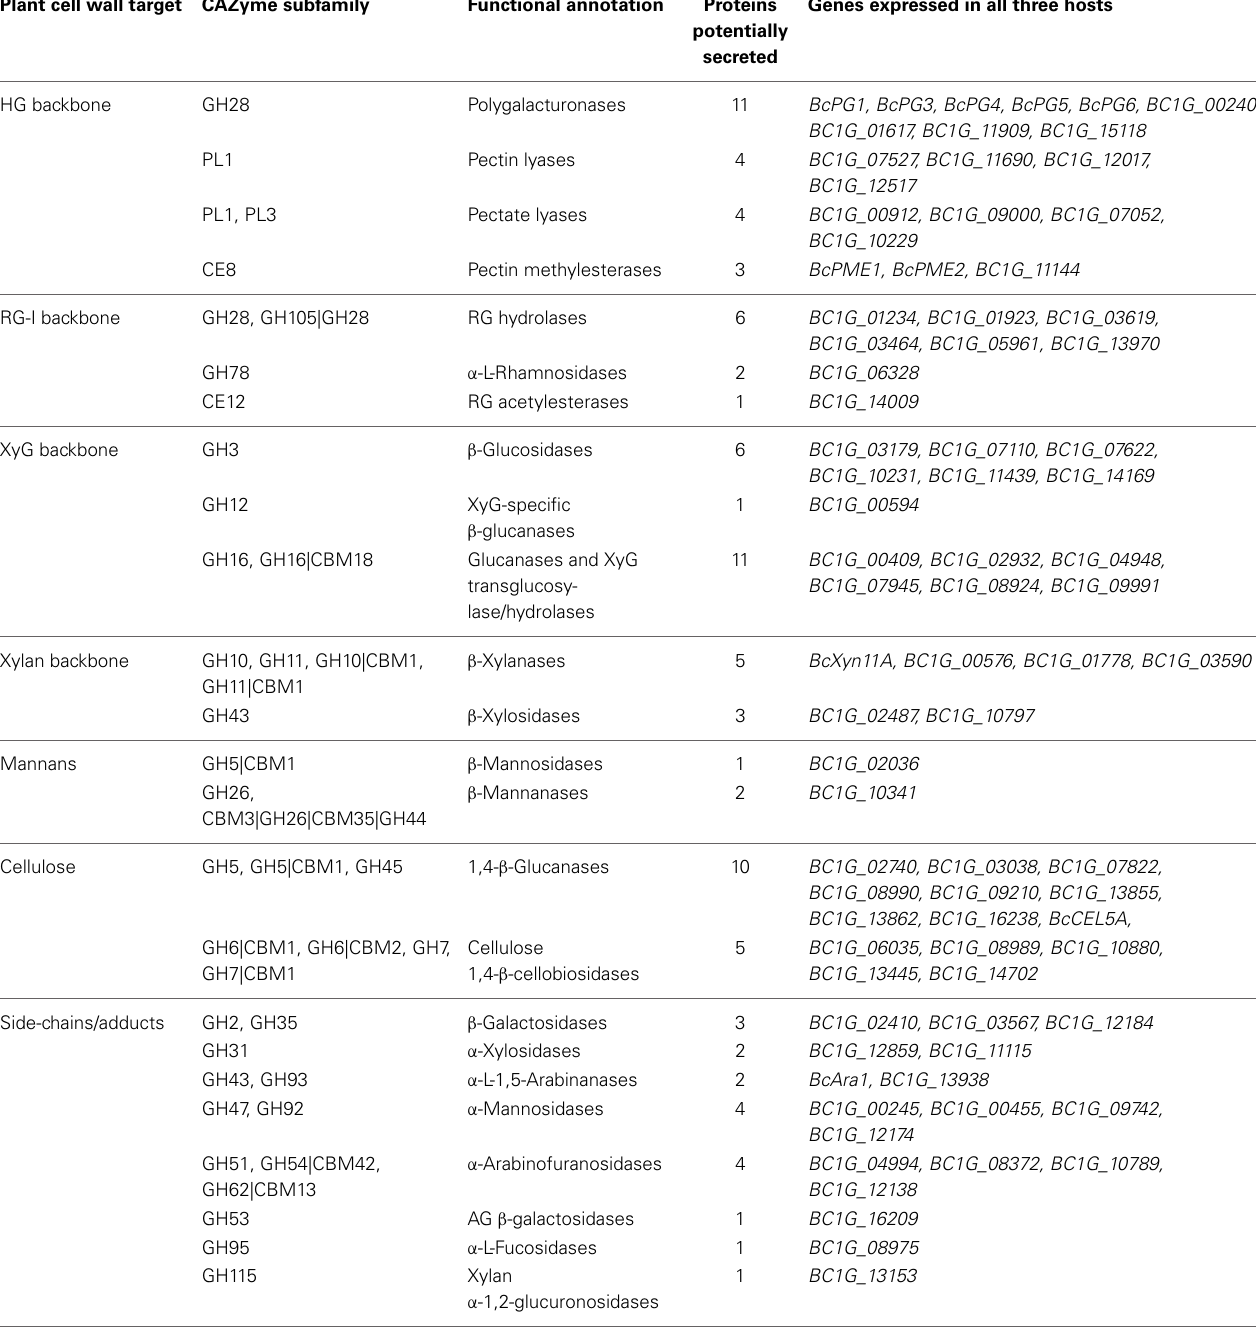
Table 2 | Annotated secreted Botrytis enzymes involved in plant cell wall